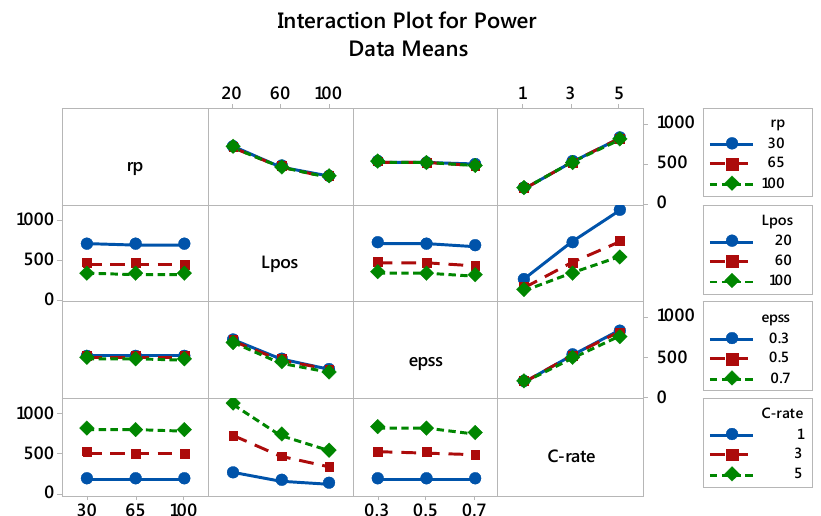
Figure 7. Interaction effect of design parameters, particle size ( r p ), electrode thickness ( L pos ), volume fraction of the active material ( ε s , pos ) and C-rate) at different levels on the specific